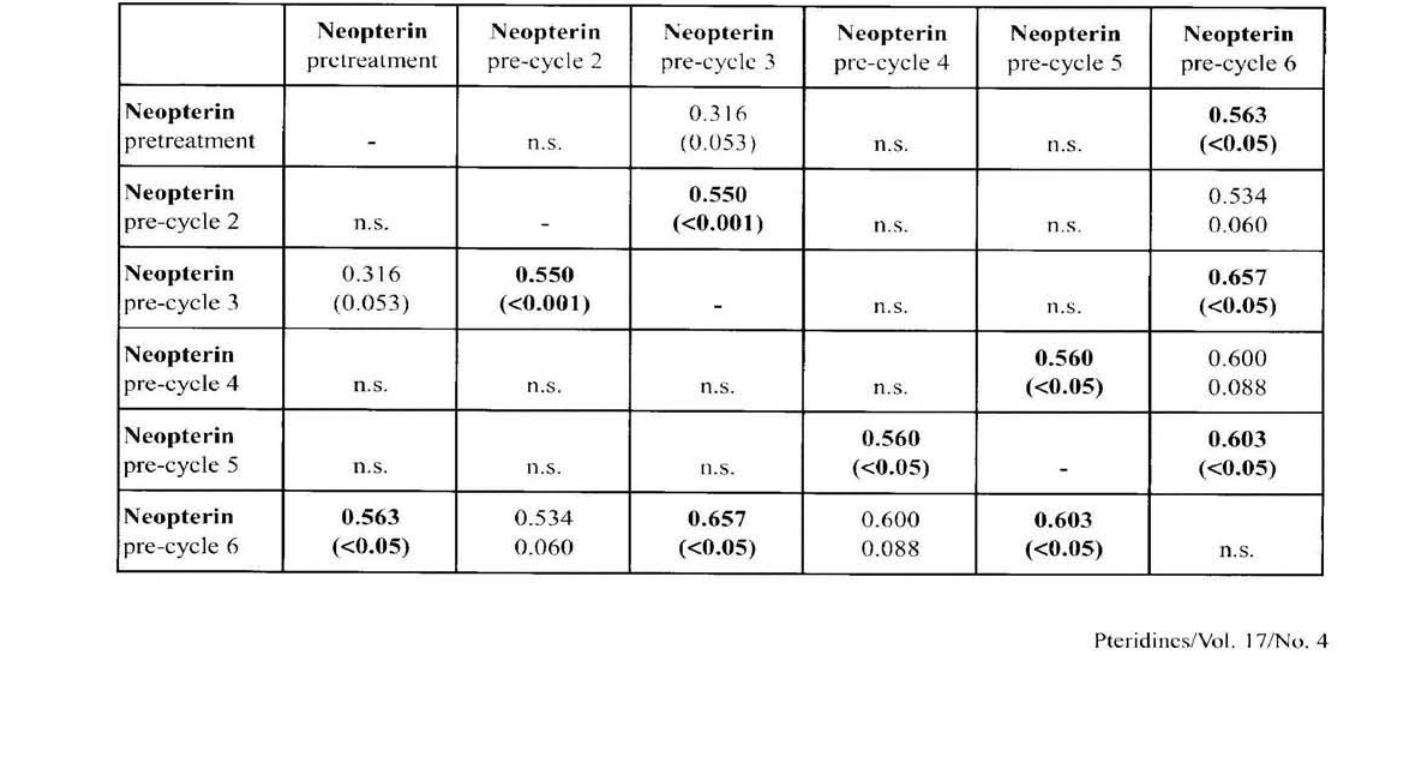
Table 5: Correlations between urinary neopterin at different time points (r s and p-values in brackets are shown, significant correlations are highlighted in bold